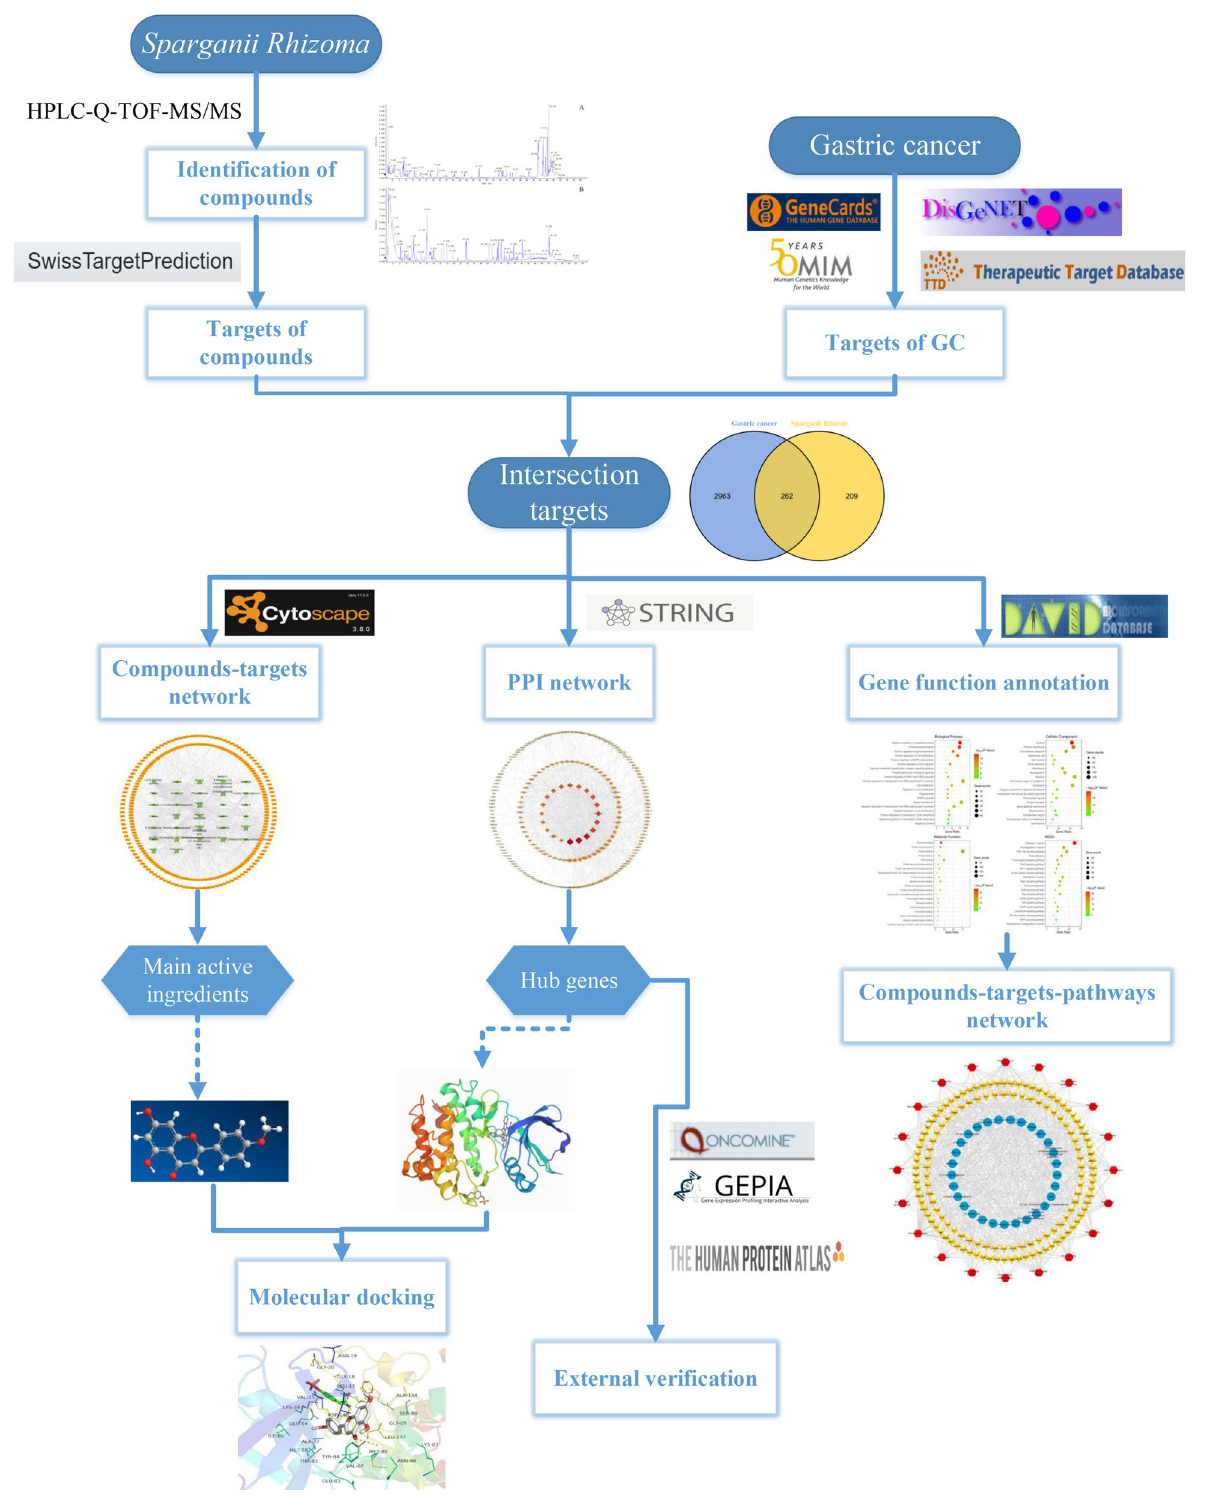
Figure 1. Scheme of analysis